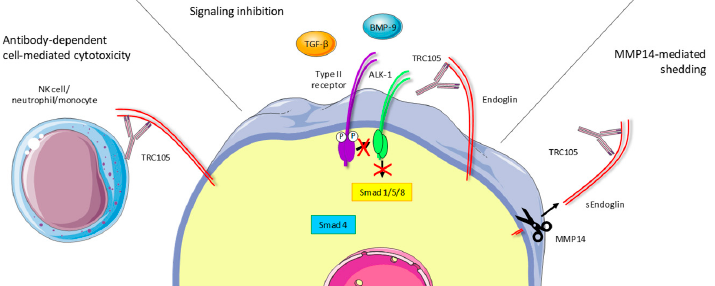
Figure 2. Proposed mechanisms of action of TRC105. TRC105 exerts its actions through different mechanisms. Firstly, binding to endoglin induces antibody ‐ dependent cell ‐ mediated cytotoxicity (ADCC) mediated by NK cells, neutrophils and monocytes, resulting in target cell killing. Secondly, TRC105 prevents BMP ‐ 9 binding to endoglin, thereby inhibiting receptor complex formation and endoglin ‐ mediated downstream signaling. Lastly, MMP ‐ 14 ‐ mediated endoglin shedding is induced upon TRC105 binding, generating soluble endoglin (sEng) which can function as a ligand trap and thus reduces endoglin signaling.